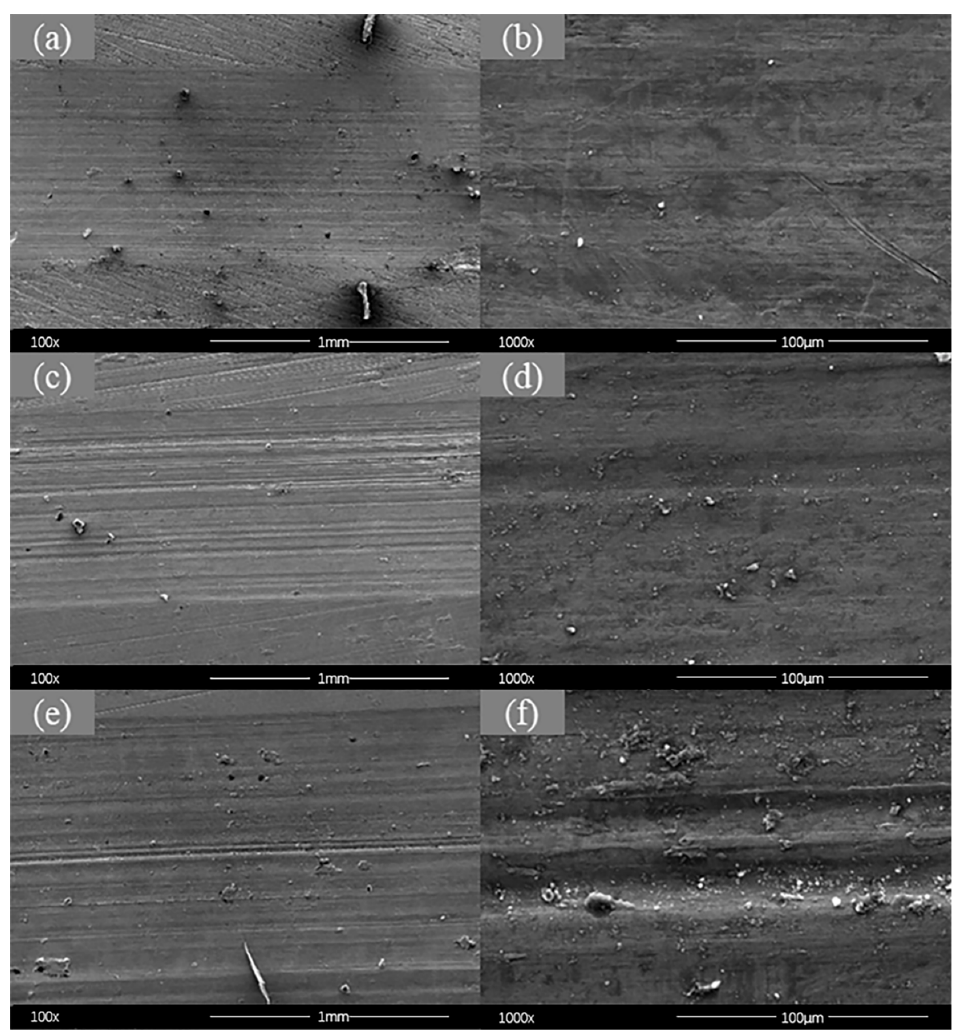
Figure 10. Wear morphology of alloying coating under different load. ( a , b ): 3 N; ( c , d ): 6 N; ( e , f ): 9 N.